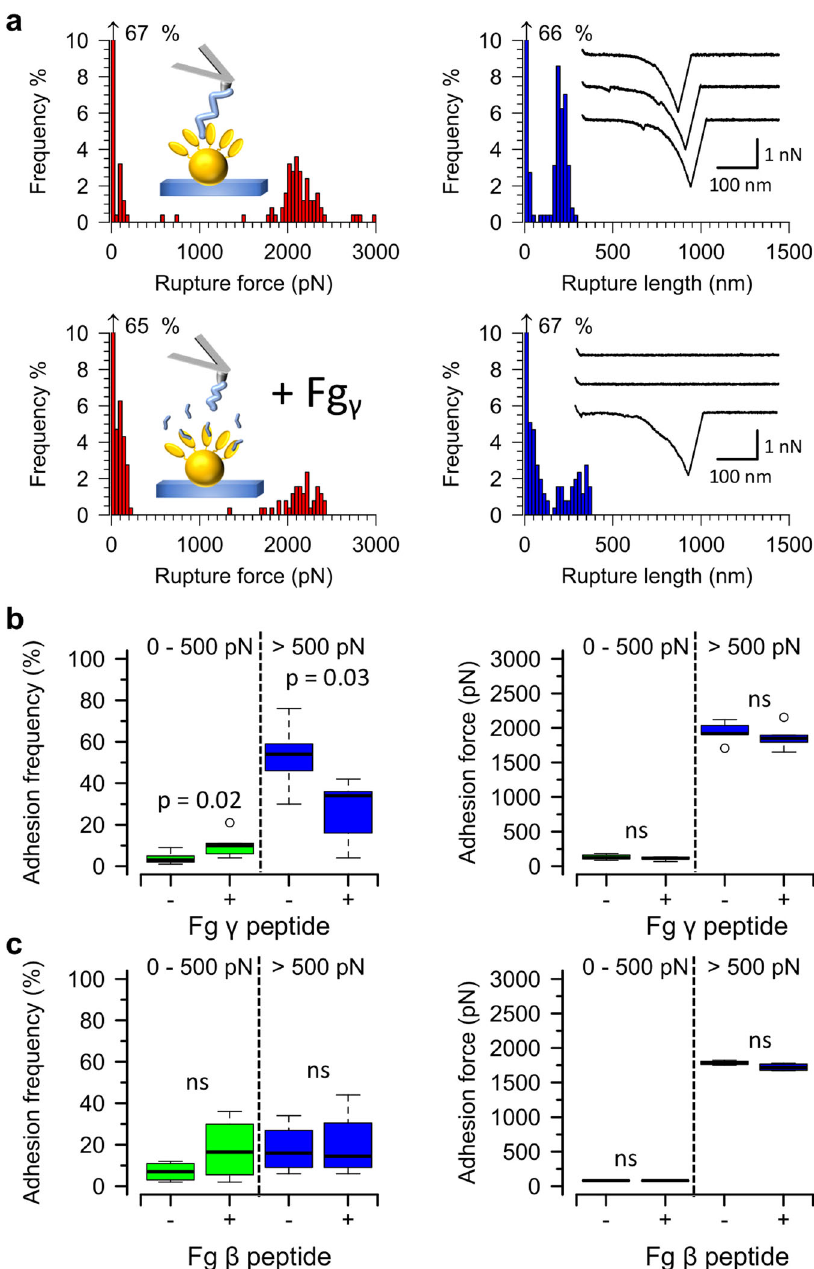
Fig. 4 Inhibition of FnBPB-loricrin interaction by the fi brinogen gamma-chain peptide suggests a possible DLL mechanism. AFM tips modi fi ed with loricrin were used to probe single exponentially growing staphylococcal cells induced to express FnBPB. a Data for one representative S. aureus SH1000 4X (pFnBPB) cell before and after the fi brinogen (Fg) γ -chain C-terminal peptide (100 µ g ml − 1 ) was injected into the Petri dish. Left. Histogram plots of rupture forces. Right. Histogram plots of rupture lengths with inset showing three representative curves. b Boxplots of adhesion forces and frequencies for S. aureus SH1000 4X (pFnBPB) [FnBPB + ] cells ( n = 6 cells) before ( − ) and after ( + ) incubation with the Fg γ -chain C-terminal peptide. c Boxplots of adhesion forces and frequencies for SH1000 4X (pFnBPB) cells ( n = 4 cells) before ( − ) and after ( + ) incubation with the Fg β -chain N-terminal peptide (Fg β peptide). Whiskers show the range, the boxes the interquartile range, the thick lines within the boxes the median and open circles outliers. Differences in data distributions were assessed using a two-sided Mann – Whitney U -test. ns not signi fi cant. P >